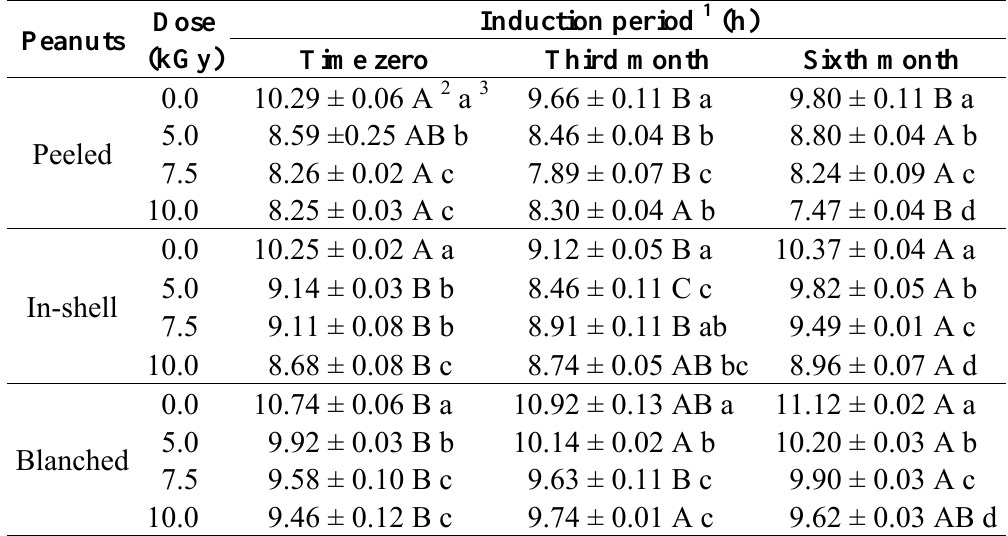
Table 5. Induction period (h) of the crude peanut oils 1 .